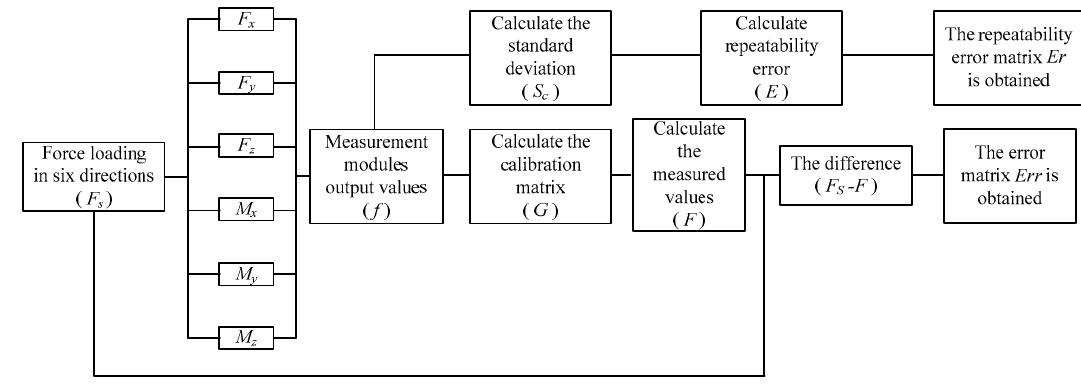
Figure 9. Flow chart of calibration experiment.